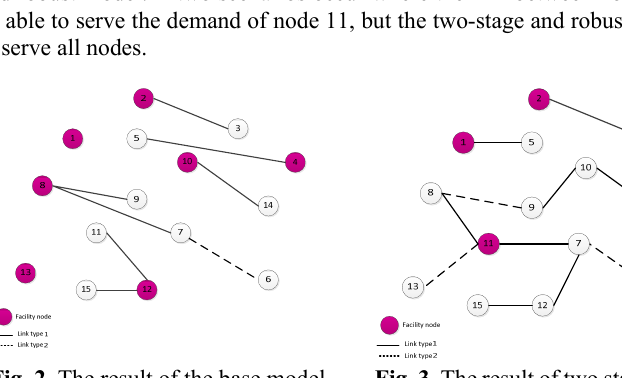
Fig. 4. The result of robust model